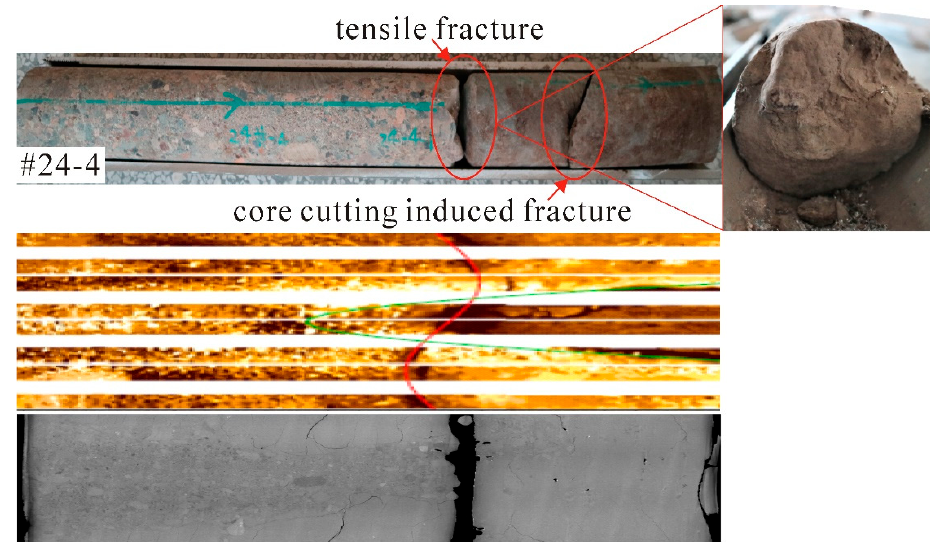
Figure 9. Tensile fracture is microwave in morphology and has a bypassing gravel surface. Shear fractures are created by an induced stress field with the growth of the principal hydraulic fractures along natural weak planes. These shear fractures can also be formed by shear failure or the bifurcation and splitting of principal fractures during propagation. Thus, shear fractures are mainly straight and crushed zones in morphology. These fractures mainly have small apertures and through-penetrating gravel surfaces. Where shear fractures occur, fracture orientations change slightly and fracture swarms and crushed zones are common. Figure 10 shows conjugate shear fracture and crushed zone in the slant core. Conjugate shear fractures were observed in cores, forming scissor-shaped fracture planes. Moreover, crushed zones are prone to forming when shear slip occurs at the weak-cemented planes; some of these occur close to fracture swarms.